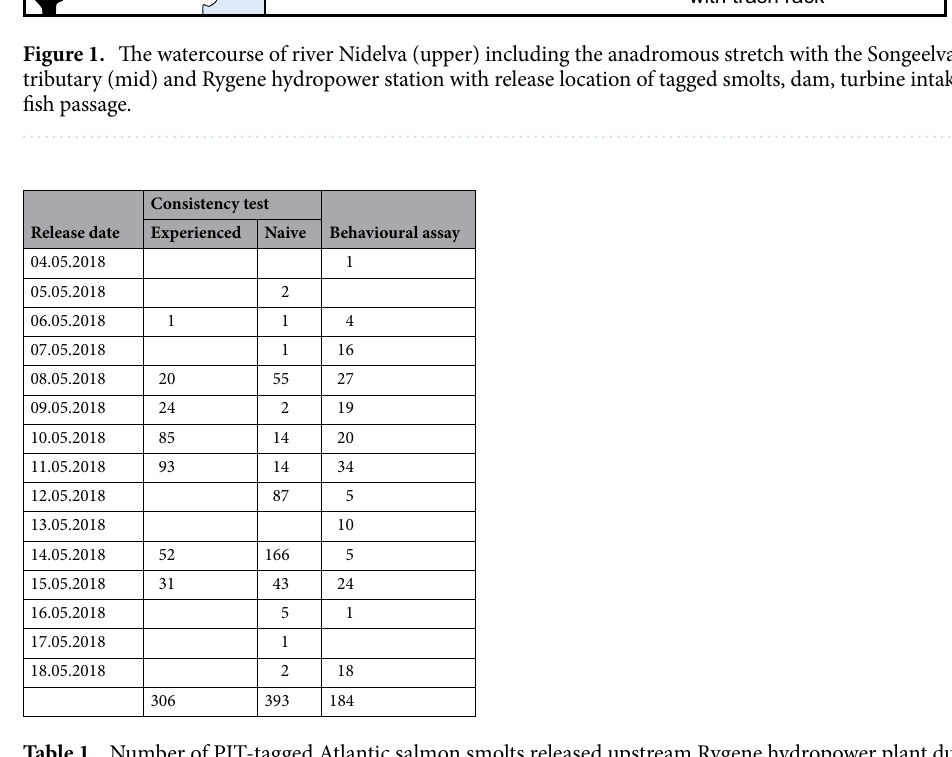
Table 1. Number of PIT-tagged Atlantic salmon smolts released upstream Rygene hydropower plant during 2018 smolt migration period. Experienced smolts were caught in the trap at Rygene fish passage while naive smolts were caught in Songeelva tributary. All smolts that went through behavioural assays were naive, caught in Songeelva